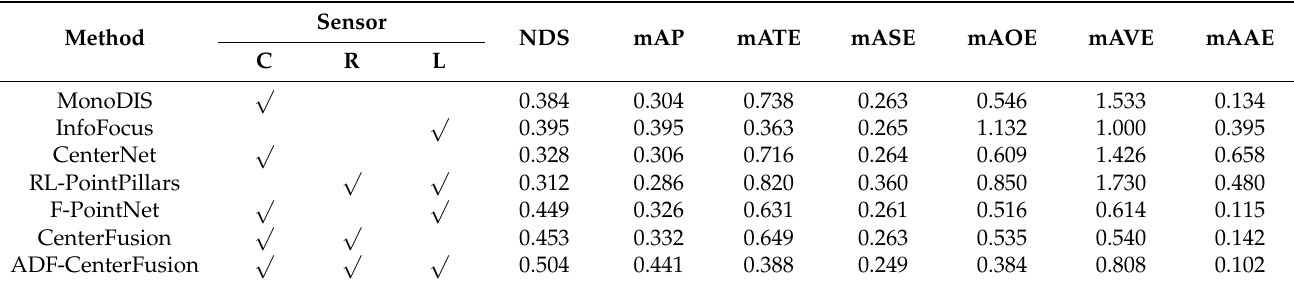
Table 2. Performance comparison for 3D object detection on nuScenes dataset. “C”, “R”, and “L” specify camera, mmWave radar, and LiDAR modalities, respectively.